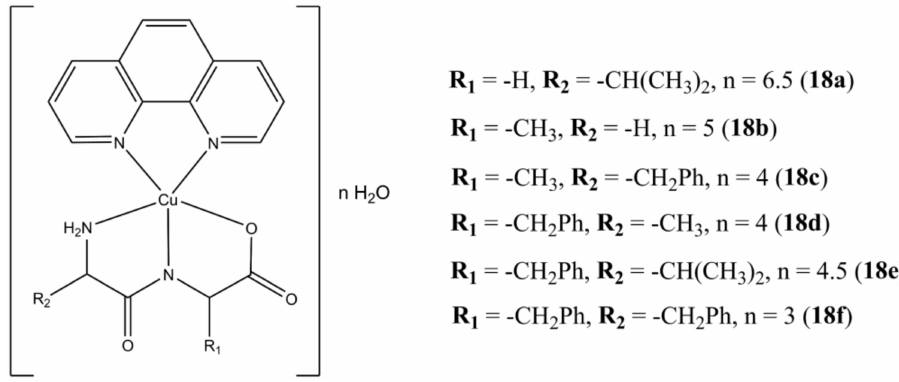
Figure 18. Structure of the [Cu(L-dipeptide)(phen)] · nH 2 O complexes.